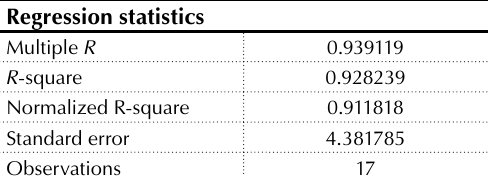
Table 5. Calculated indicators of state debt regression